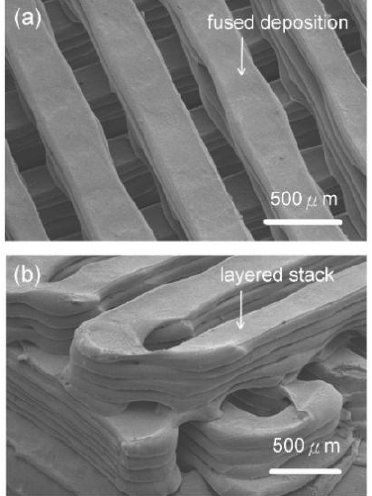
Figure 3. The 3D printed PLA (Polylactic Acid, -(C3H4O2)-) layers of a multilayer structure based on the fused deposition modeling (FDM) method, primarily highlighting the design of grid microstructures with: ( a ) The cross mesh of fused deposition with a line width of about 350 µ m and spacing of about 300 µ m; ( b ) the layered stack of one single line deposition of the cross mesh with a slicing layer thickness of 100 µ